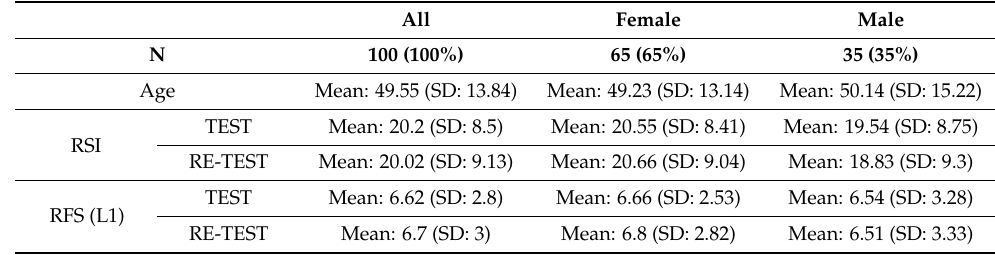
Table 3. Baseline statistics of the main study